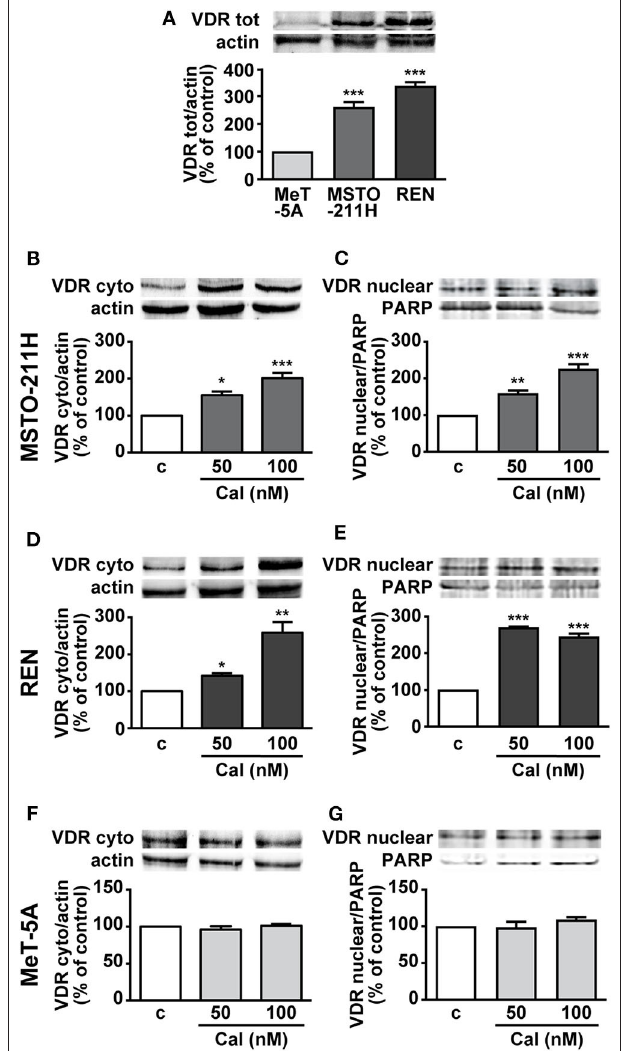
FIGURE 1 | Expression of VDR in MPM cell lines and mesothelial cells. (A) Total VDR protein assessed by Western blot in MSTO-211H, REN and MeT-5A cells. Results, normalized to actin and expressed as percent of control are means ± SEM. *** P < 0.001 vs. MeT-5A; n = 3. Cytosolic and nuclear VDR in MSTO-211H (B,C) , REN (D,E) and MeT-5A cells (F,G) , that were serum deprived for 12h and either untreated (c, control) or treated for 24h with calcitriol (Cal), at the concentrations indicated. Blots are representative of three independent experiments. Results, normalized to actin and PARP for cytoplasmic or nuclear VDR, respectively, are expressed as percent of control and are means ± SEM. * P < 0.05, ** P < 0.01, *** P < 0.001 vs. c.; n = 3.